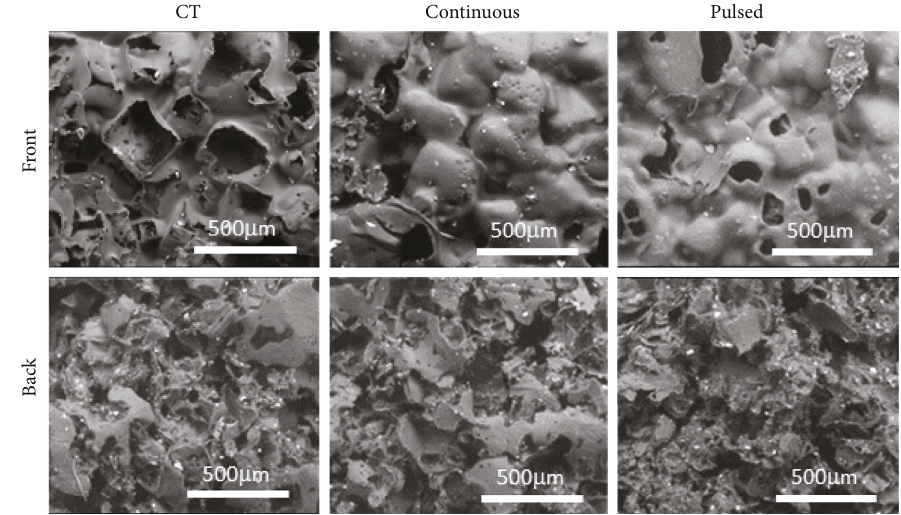
Figure 9: SEM images for untreated (CT) and plasma-treated